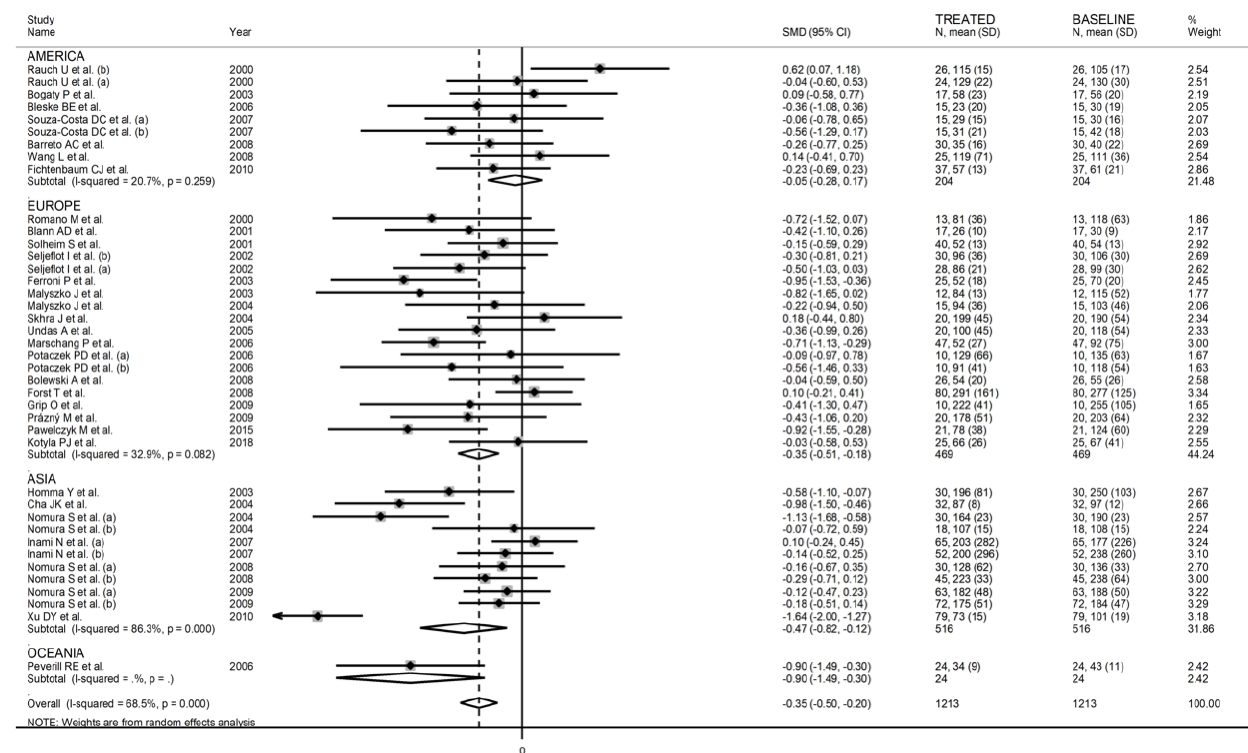
Figure 6. Forest plot of P-Selectin concentrations before and after statin treatment according to individual agents.